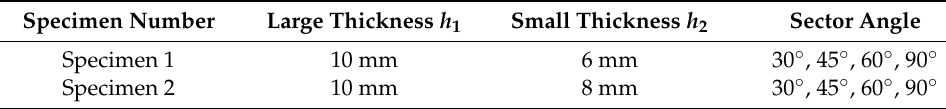
Figure 13. Diagram of the circular step specimen. Table 2. Parameter table of the step